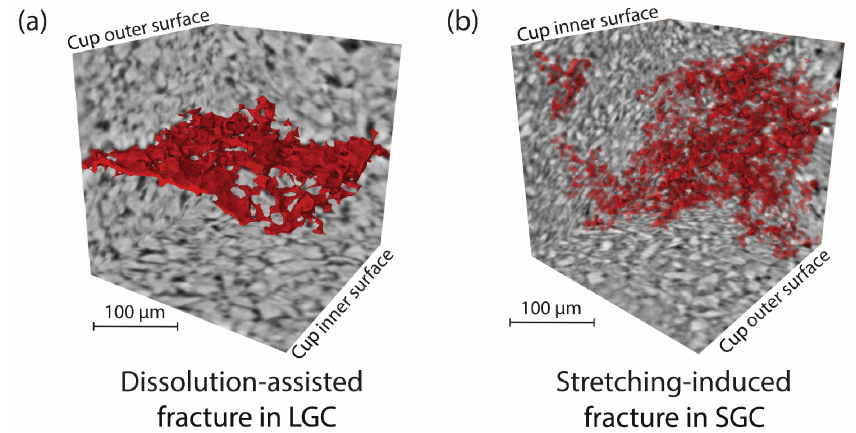
Figure 10. The 3-D geometry (in red) of (a) dissolution-assisted fracture in LGC is distinctively different from (b) the stretching-induced fractures in SGC. Both displayed volumes are 260 × 260 × 260µm 3 in